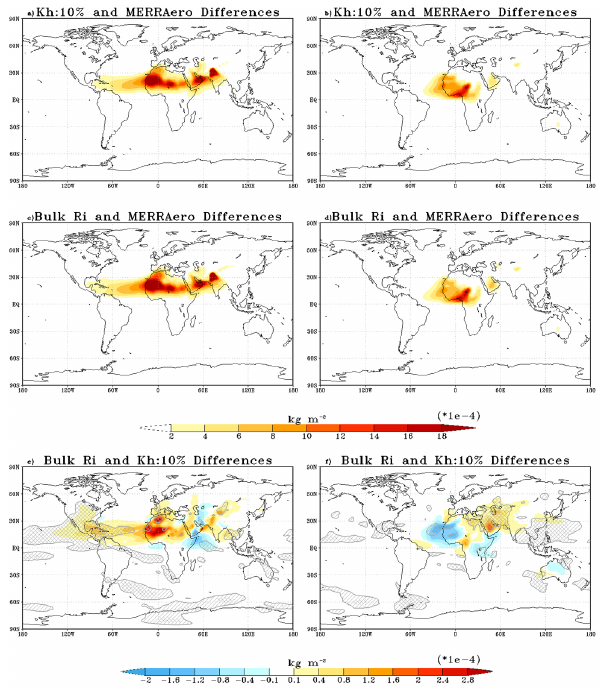
Figure 14. Seasonal mean column dust differences. Method 2 mi- nus MERRAero for JJA (a) and DJF (b) , Method 3 minus MER- RAero for JJA (c) and DJF (d) , and Method 3 minus Method 2 for JJA (e) and DJF (f) . Global mean column dust concentrations in the free-running models is about 1.2 × 10 − 4 kgm − 2 during JJA and about 5.7 × 10 − 5 kgm − 2 during DJF. Hatch marks on the bot- tom plots represent significance at the 90% level using the Student’s t test. Crosshatch marks represent significance at the 95% level.